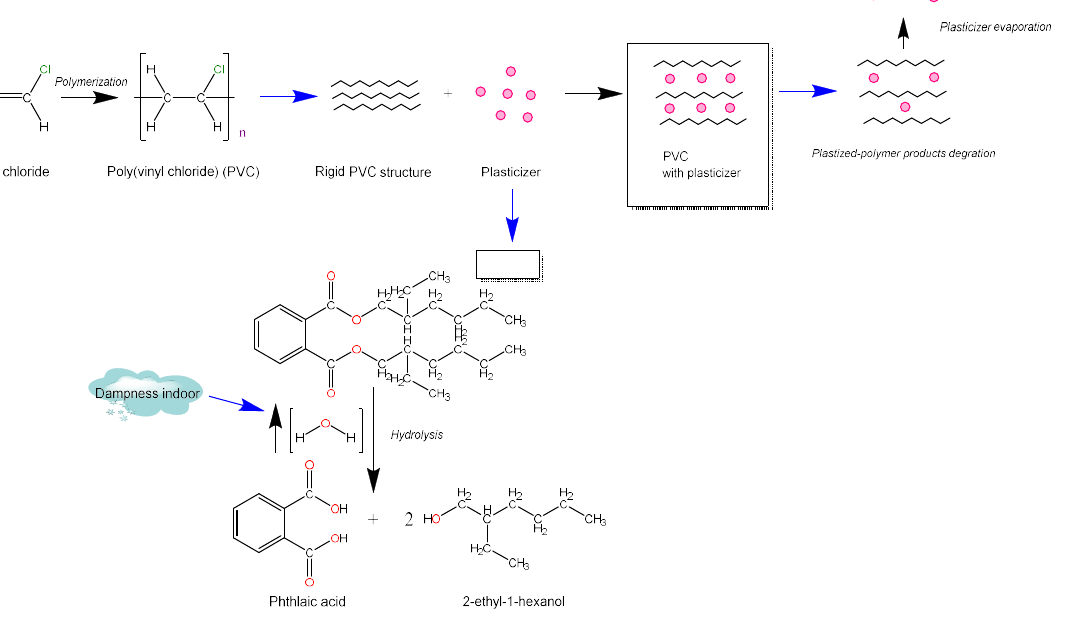
Figure 7. Production of 2-ethyl-1-hexanol detected in human exhaled breath in presence of residential humidity.